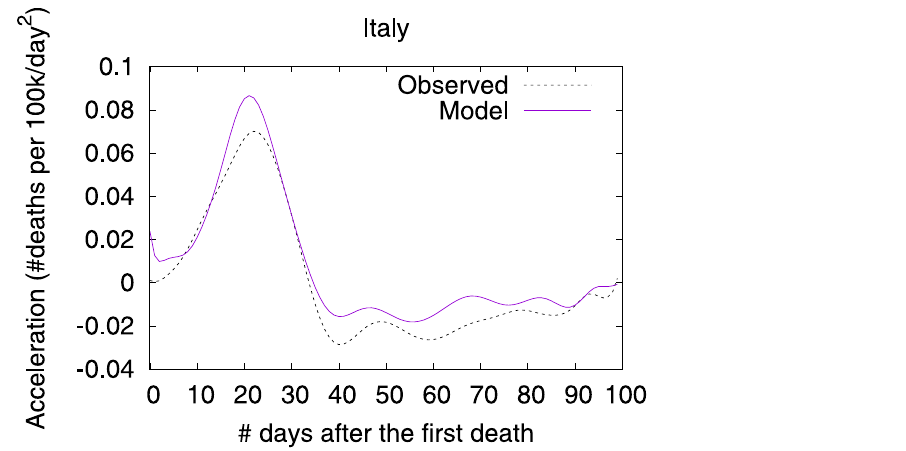
Fig 8. (Color online) projections for acceleration in Italy.